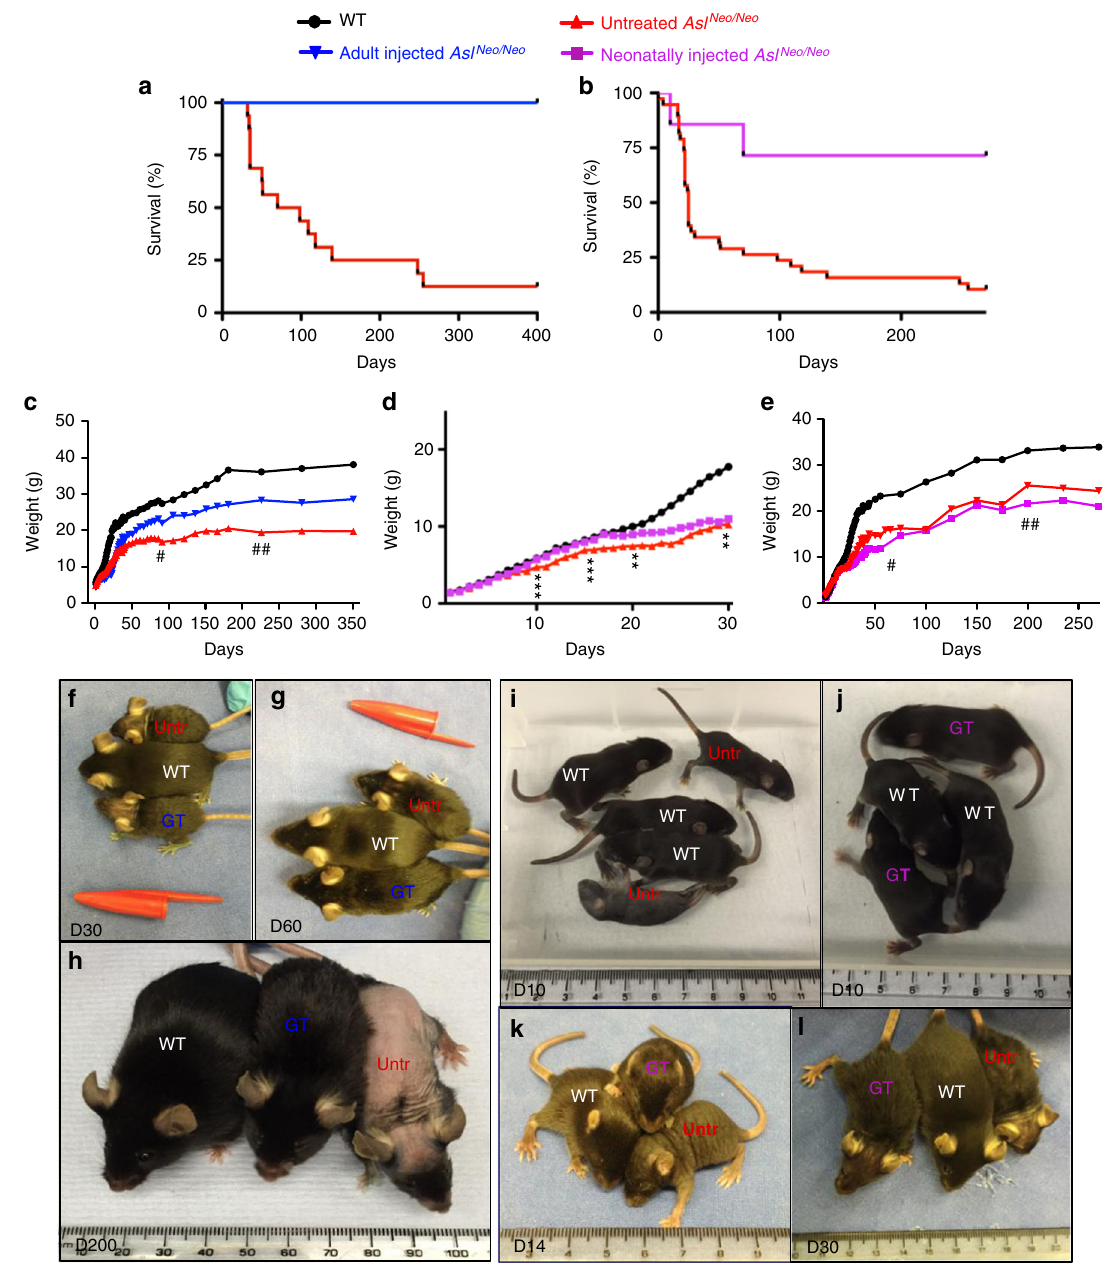
Fig. 3 Systemic injection of AAV8.EFS. mAsl sustainably improves the macroscopic phenotype of Asl Neo/Neo mice injected as adults but only transiently after neonatal injection. a Survival curve of adult-injected Asl Neo/Neo mice ( n = 5/5) compared to untreated Asl Neo/Neo mice ( n = 2/16); Log rank test p = 0.003. b Survival curve of neonatally injected Asl Neo/Neo mice ( n = 5/7) compared to untreated Asl Neo/Neo mice ( n = 2/21); Log rank test p = 0.006. c Mean growth of adult-injected Asl Neo/Neo mice ( n = 5) compared to WT ( n = 11) and untreated Asl Neo/Neo mice over 12 months ( n = 19). d , e Mean growth of neonatally injected Asl Neo/Neo mice compared to WT ( n = 31) and untreated Asl Neo/Neo mice ( n = 41) d during the fi rst month ( n = 13) and e over 9 months ( n = 7). f − h Images of WT, untreated Asl Neo/Neo (Untr), and adult-injected Asl Neo/Neo mice with gene therapy (GT). i − l Images of WT, untreated Asl Neo/ Neo (Untr) and neonatally injected Asl Neo/Neo mice (GT). Unpaired two-tailed Student ’ s t test ** p < 0.01, *** p < 0.001, neonatally injected vs. untreated Asl Neo/Neo mice. # 30% and ##<15% of untreated Asl Neo/Neo mice still alive; scale bar f − l 1